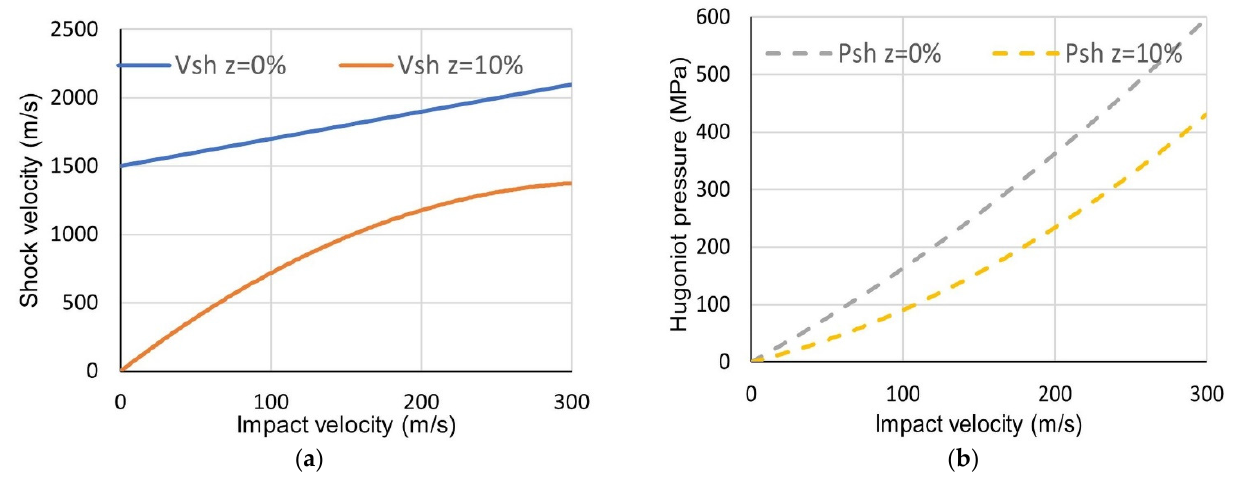
Figure 4. Theoretical results for shock velocity ( a ) and shock pressure ( b ) with different porosity. Adapted from Ref. [19].